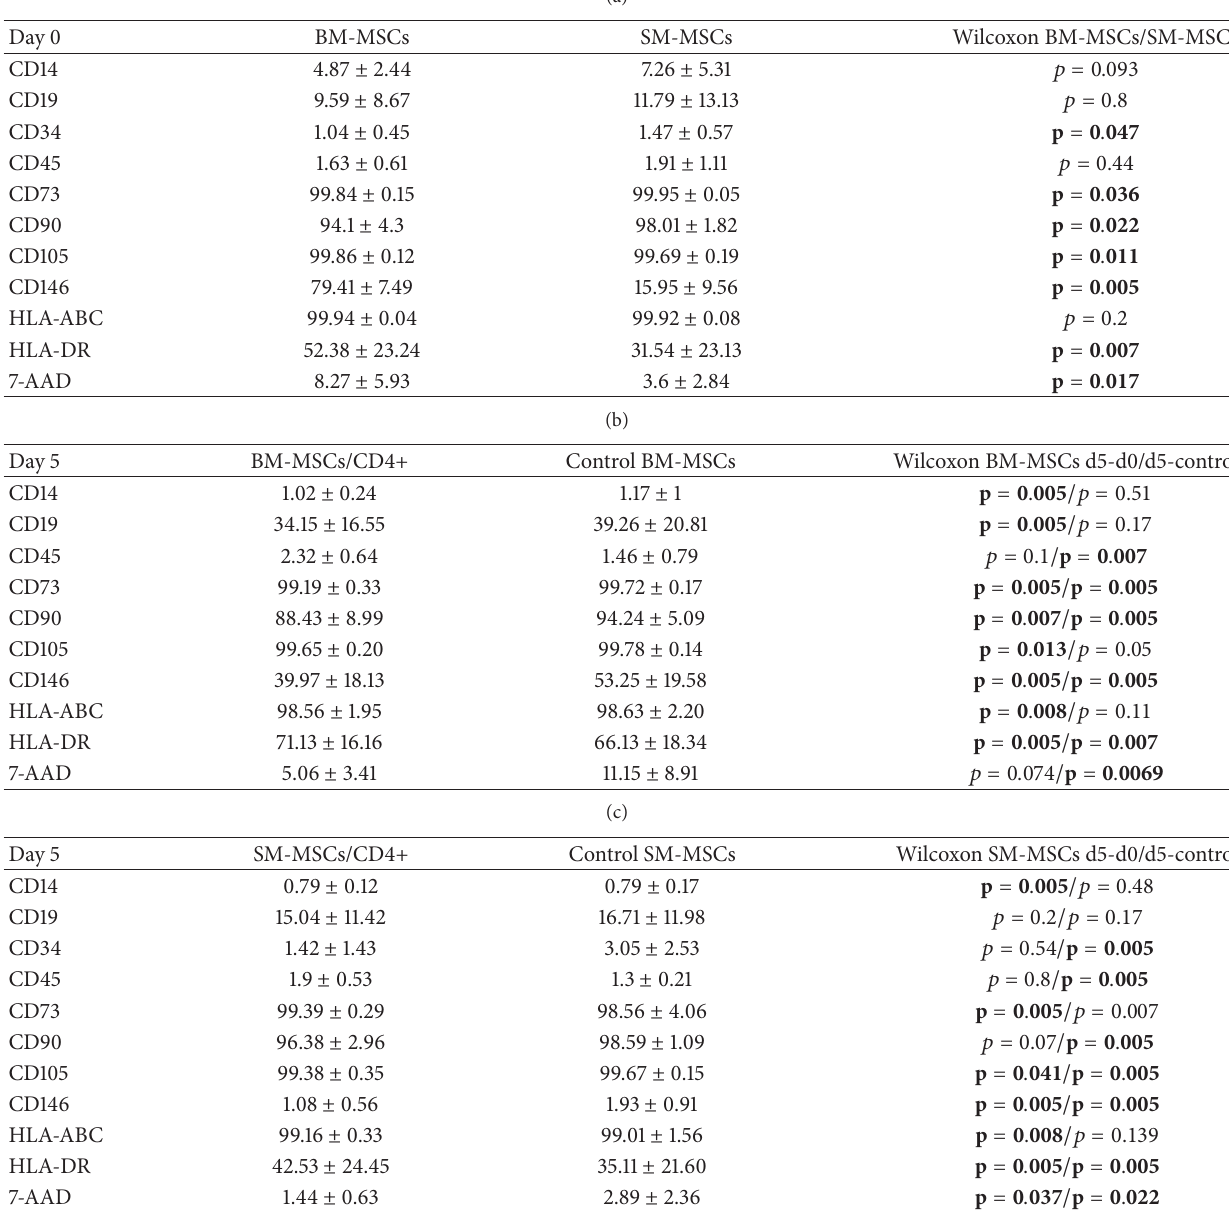
Table 1: Surface marker expression and 7-AAD staining on bone-marrow (BM) and synovial membrane (SM) derived mesenchymal stromal cells (MSCs) from osteoarthritis patients, detected by flow cytometry at d0 before coculture. Results are displayed as % positive cells, means ± standard deviation. Wilcoxon signed rank tests were performed to compare two groups (BM-MSCs and SM-MSCs at day 0, d0 and d5 expression results, and d5 coculture and control results). Bold 𝑝 values are beyond the significance level of